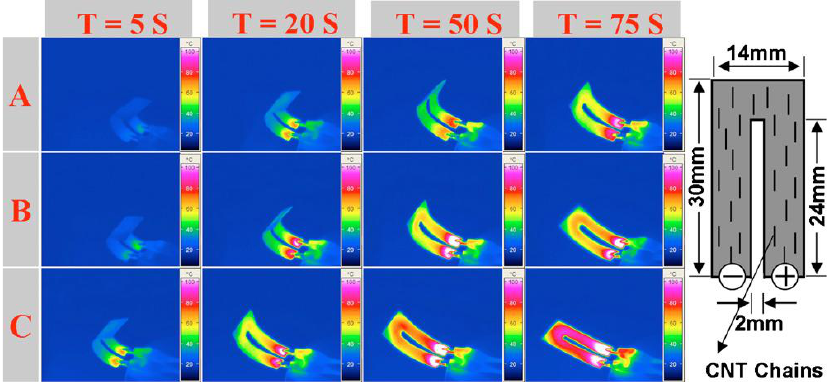
Figure 3. Snapshot of shape recovery process (and temperature distribution). Sample A: SMP/CB; Sample B: SMP/CB/CNT (random); Sample C: SMP/CB/CNT (chained). Right inset: sample dimension and experimental setup for Sample C. Reproduced with permission from [46].Copyright 2011 American Institute of